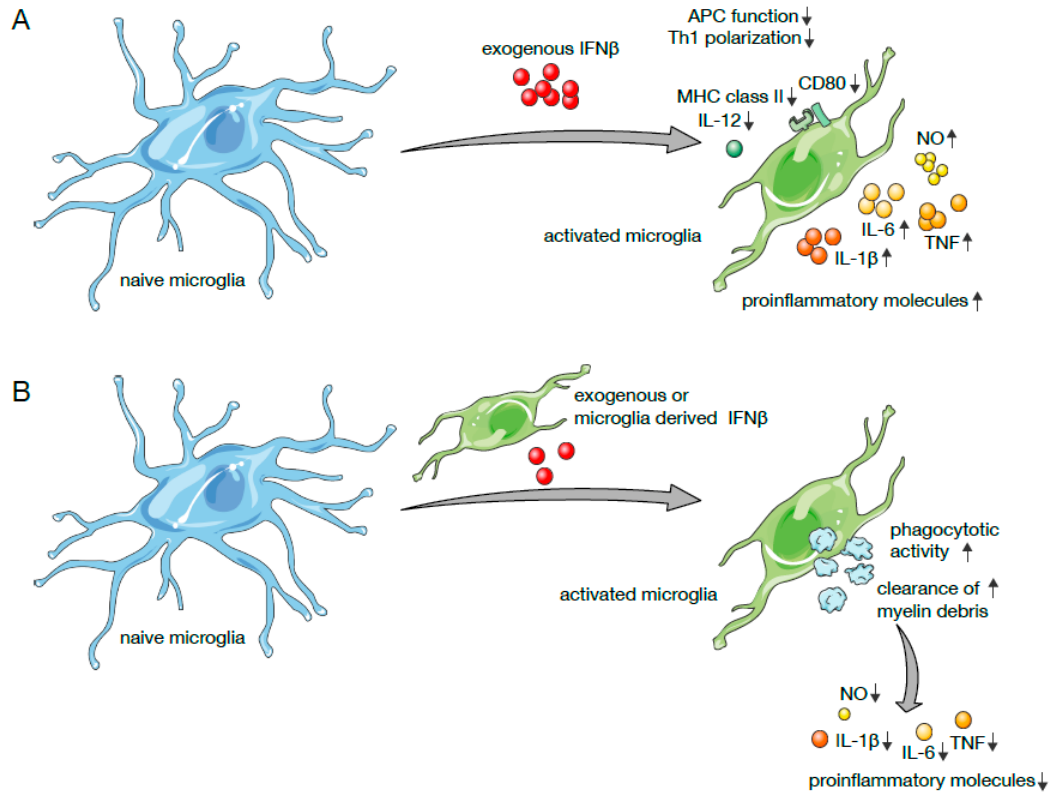
Figure 1. Molecular effects mediated by IFN β on microglia cells: ( A ) Exogenously added IFN β downregulates antigen presenting functions such as expression of MHC class II and costimulatory molecules and Th1 polarization while production of proinflammatory cytokines and molecules (TNF, IL-1 β , IL-6, NO) is increased. ( B ) IFN β produced by microglia or added exogenously activates phagocytic activity and increases removal of myelin debris by microglia suggested to cause downregulation of pro-inflammatory factors. Small black arrows indicate up or down regulation of expression of the respective molecules by microglia, grey arrows indicate causative effects. The panel was created using Servier Medical Art according to Creative Commons Attribution 3.0 Unported License (https://creativecommons.org/licenses/by/3.0/). Changes were made to the original cartoons.